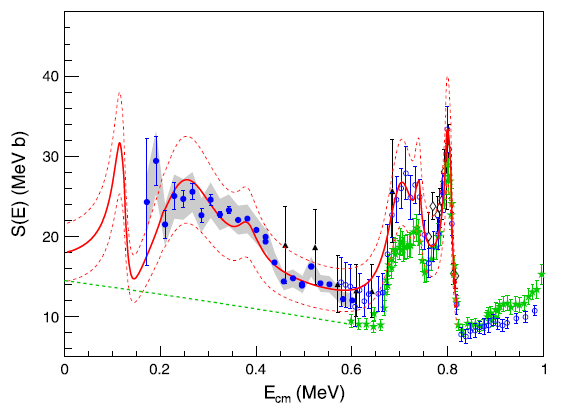
Figure 1. S-factor of the 19 F(p, α ) 16 O reaction available in literature [4]. The full and empty blue circles are from Lombardo et al. [4], the black triangles show the data of Breuer et al. [5], the green stars the data of Isoya et al. [6] and the empty diamonds the data of Caracciolo et al. [7]. The red line represents the results of the R-matrix calculation based on THM measurement, as reported in Indelicato et al.